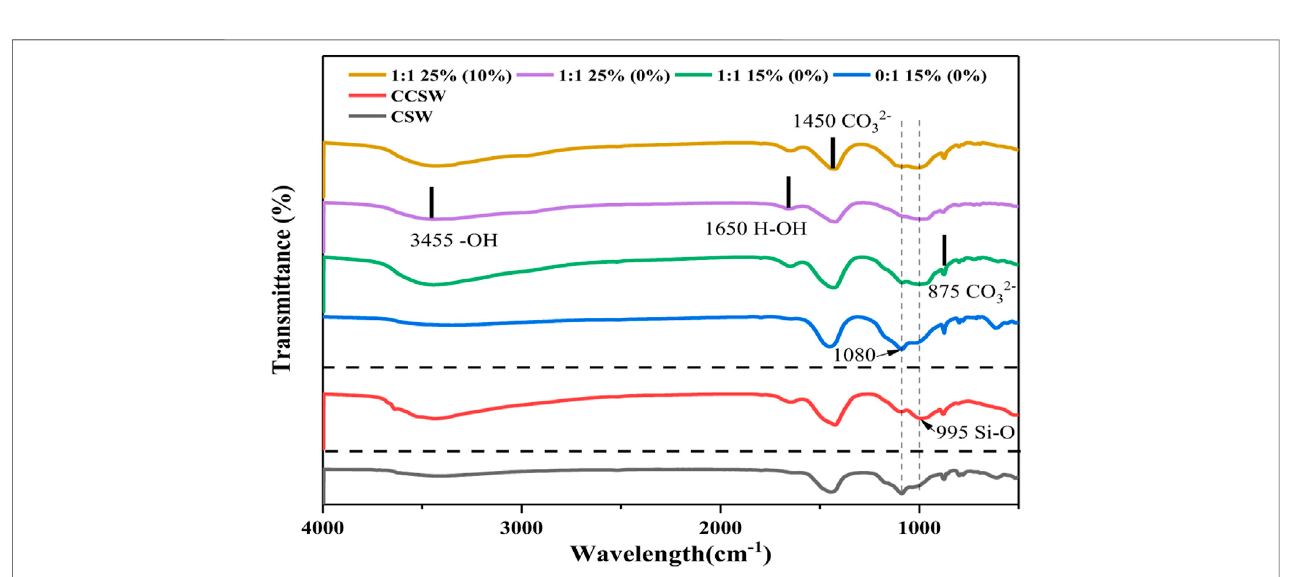
FIGURE 8 | FTIR analysis for CCSW and GCSW